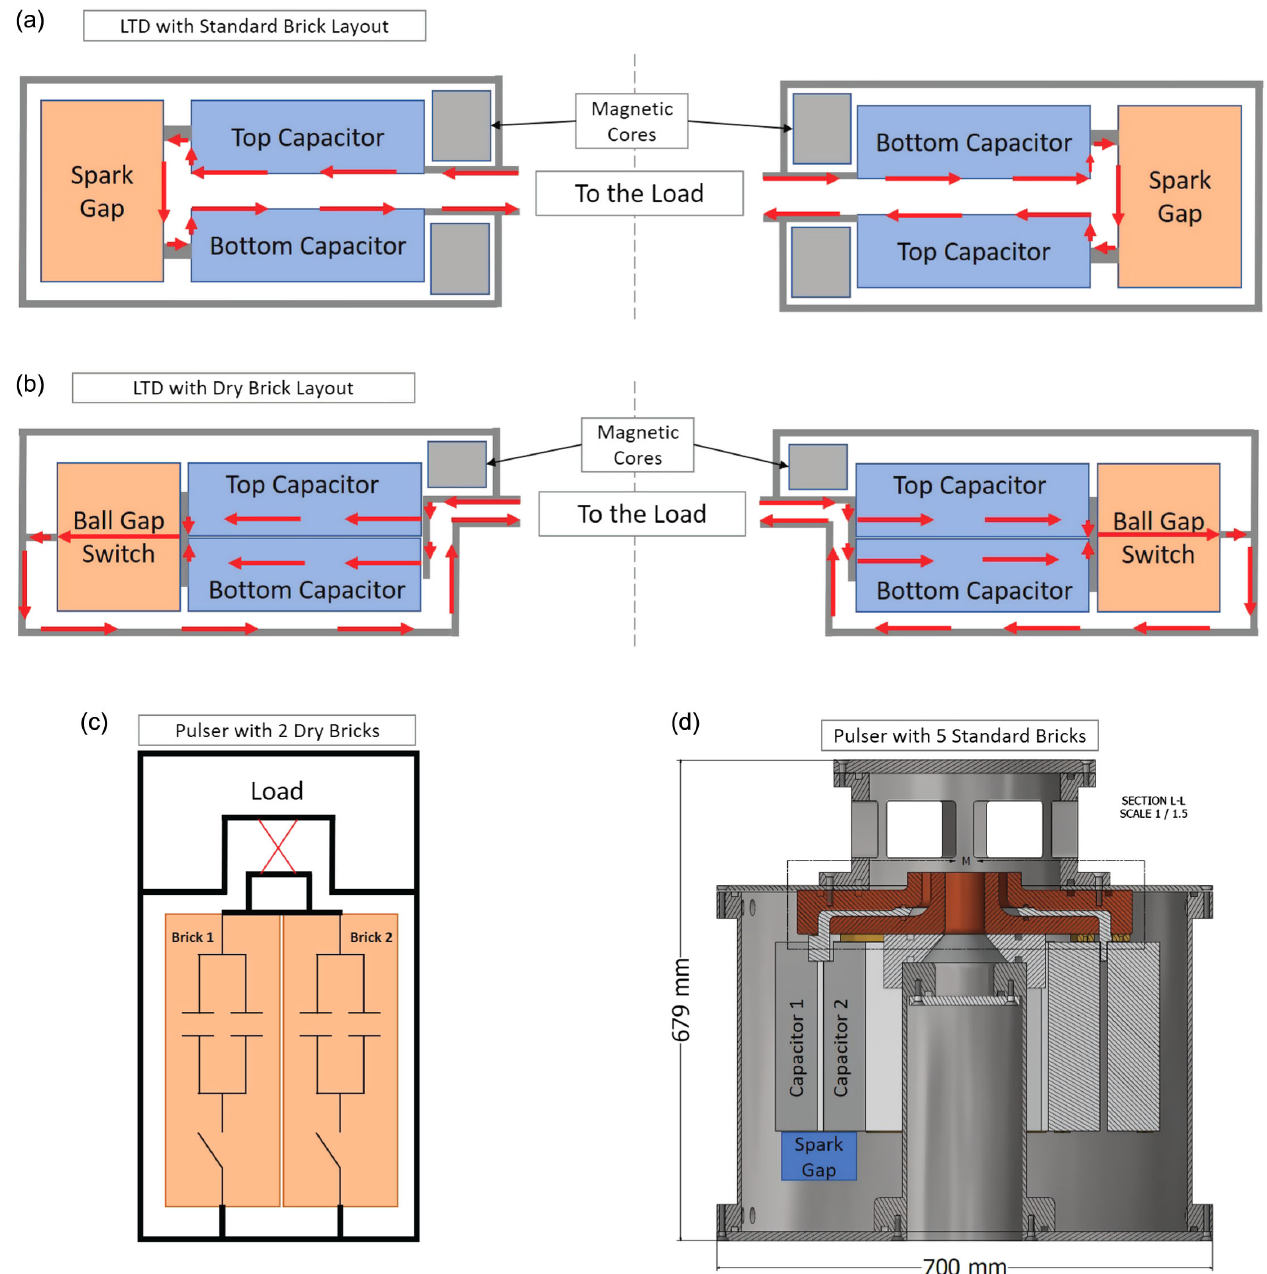
FIG. 2. Pulsers with brick outputs connected in parallel: (a) standard brick LTD; (b) dry brick LTD; (c) dry-brick pulser that uses two bricks placed side by side, with the output TL and load residing above the bricks; and (d) standard-brick pulser that uses five bricks hung vertically, with the output TL and load residing above the bricks. The pulsers in (c) and (d) are examples of compact pulsers with very small